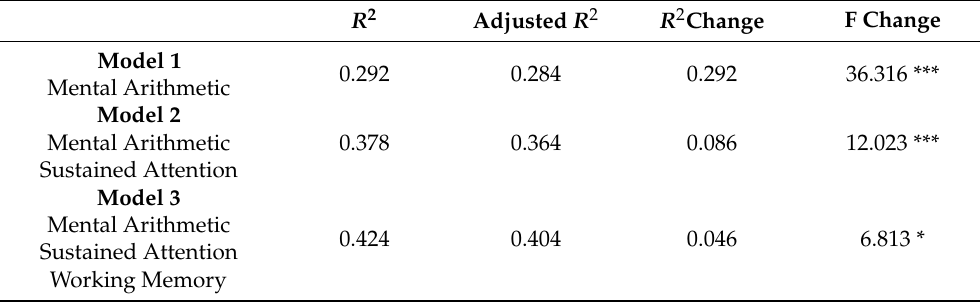
Table 2. Multiple regression analysis predicting mathematical achievement.